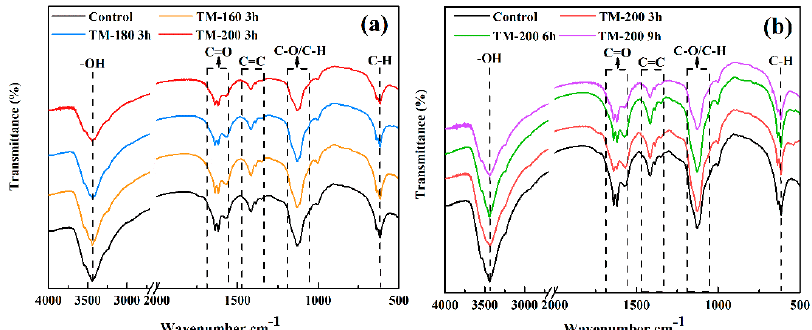
Figure 4. FTIR analysis of the control and thermally-modified wood.